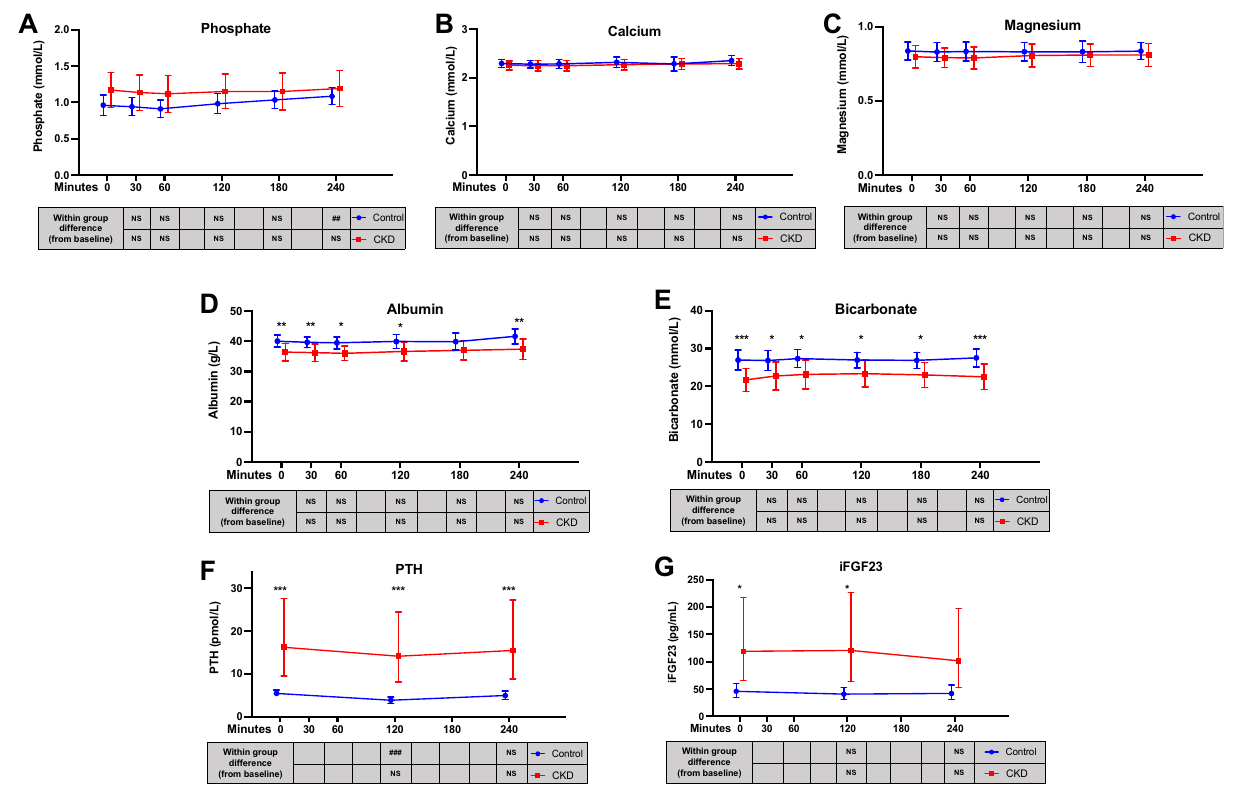
Figure 2. Post-prandial response of conventional markers of mineral metabolism after standardised meal in participants with normal and impaired kidney function. Repeated measures depicted for control and CKD group when fasting (“0”) and then post consumption of a standardised meal. Data are presented as mean and 95% confidence interval or geometric mean and 95% confidence interval. Data points have been offset for clarity. Between-group and within-group pairwise comparisons shown for each timepoint, with Bonferroni correction for multiple comparisons. (A) Phosphate; (B) calcium; (C) magnesium; (D) albumin; (E) bicarbonate; (F) intact parathyroid hormone (PTH); (G) intact fibroblast growth factor-23 (iFGF23). *p < 0.05 for CKD group versus healthy controls; **p < 0.01 for CKD group versus healthy controls; ***p < 0.001 for CKD group versus healthy controls. NS: p ≥ 0.05 versus group baseline; ##: p < 0.01 versus group baseline; ###: p < 0.001 versus group